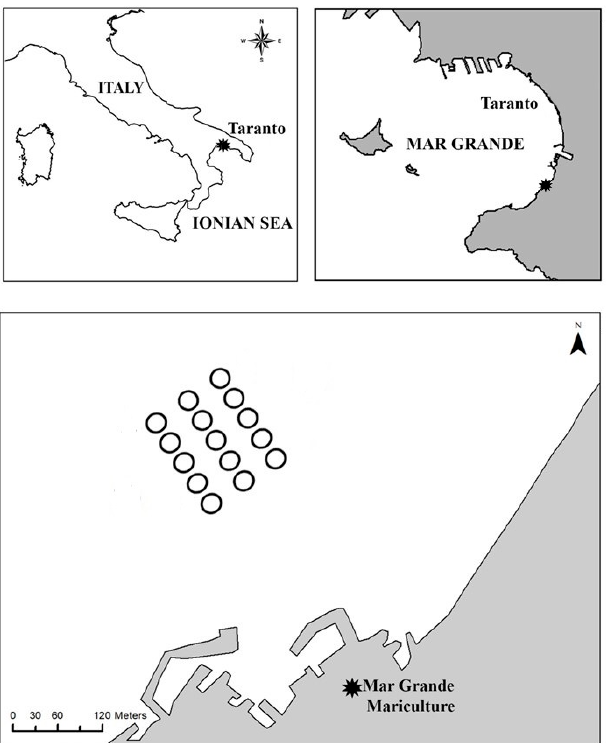
Figure 1. Study area. The star represents the location of the: Mar Grande Mariculture plant; O: fish